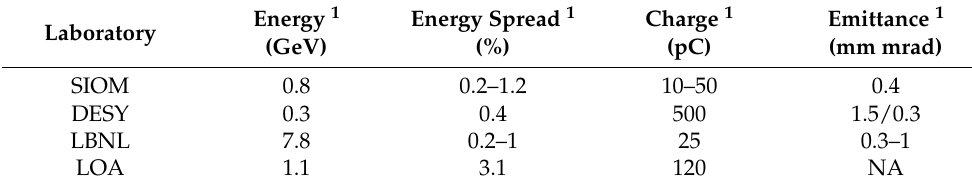
Table 1. Summary of parameters from different laboratories, as discussed in the